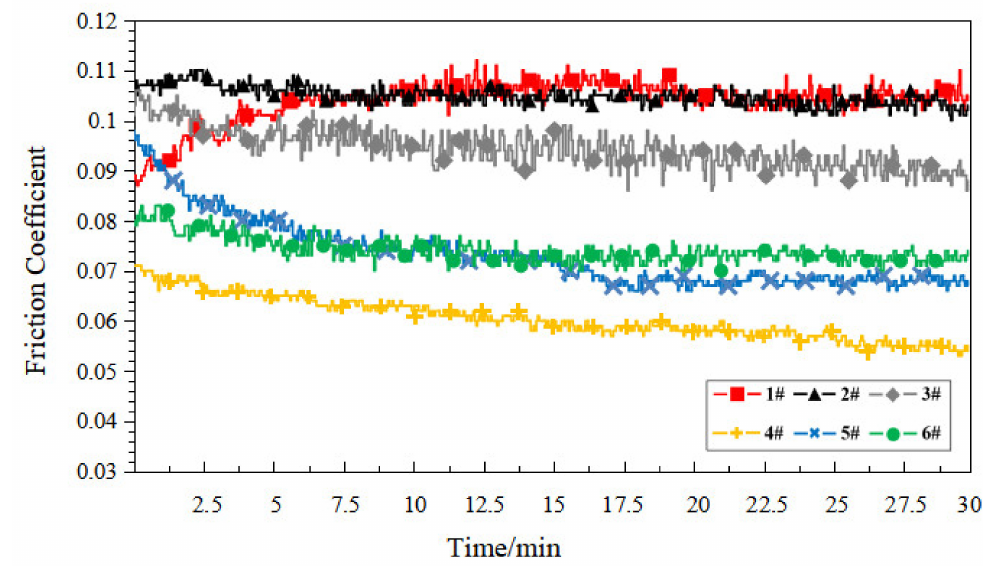
Figure 8. Friction coefficient curve of each sample under the starved lubrication